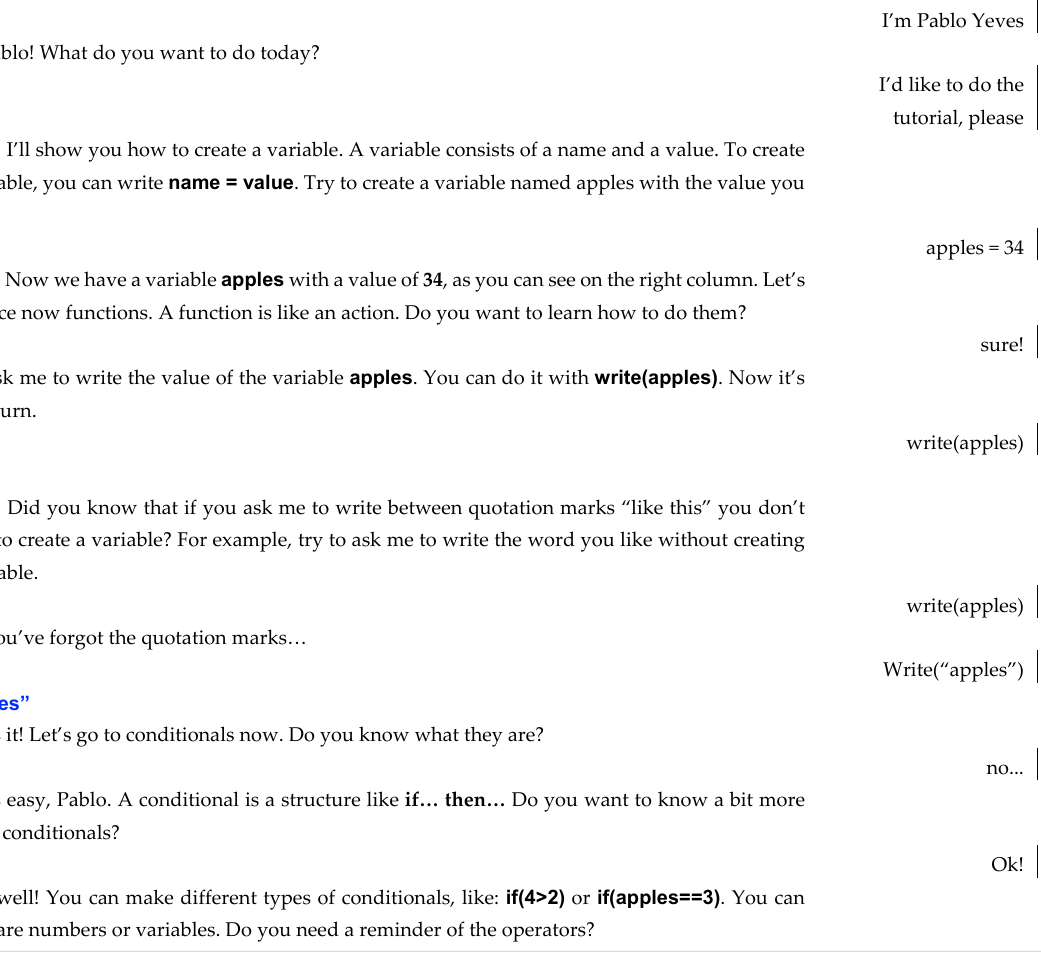
Figure 1. Example of conversation between a student and Prof. Watson. The conversation has been translated to English for the sake of English readers . However, originally the dialogue is in